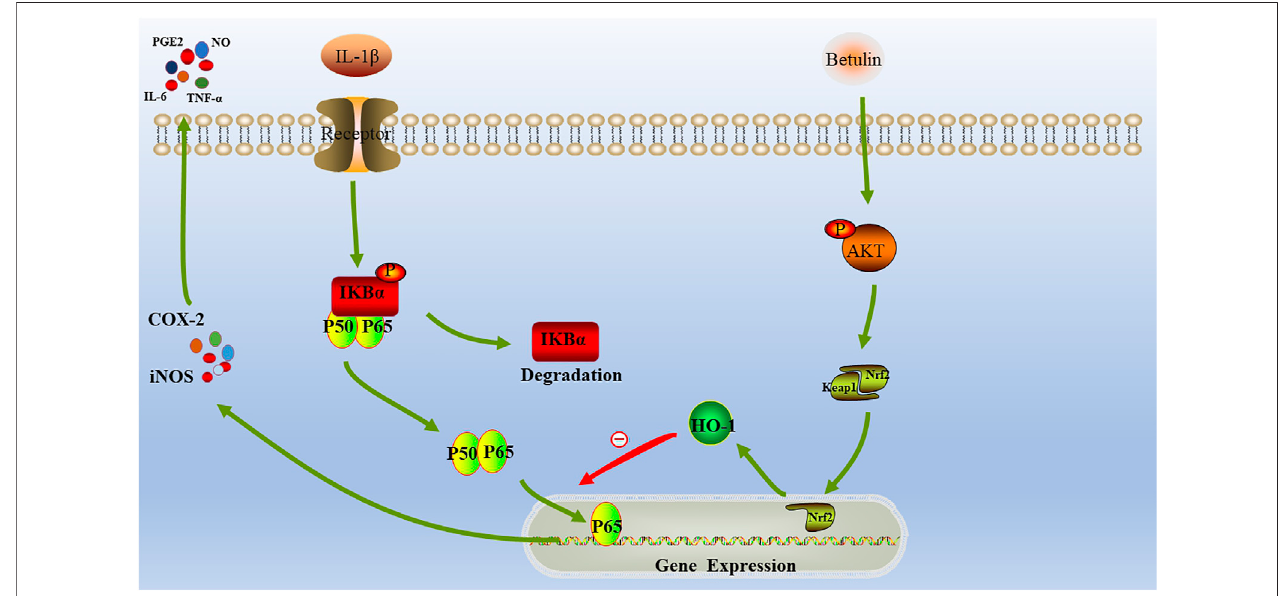
FIGURE 10 | Schematic diagram: The molecular mechanism of betulin involved in the progress of OA.